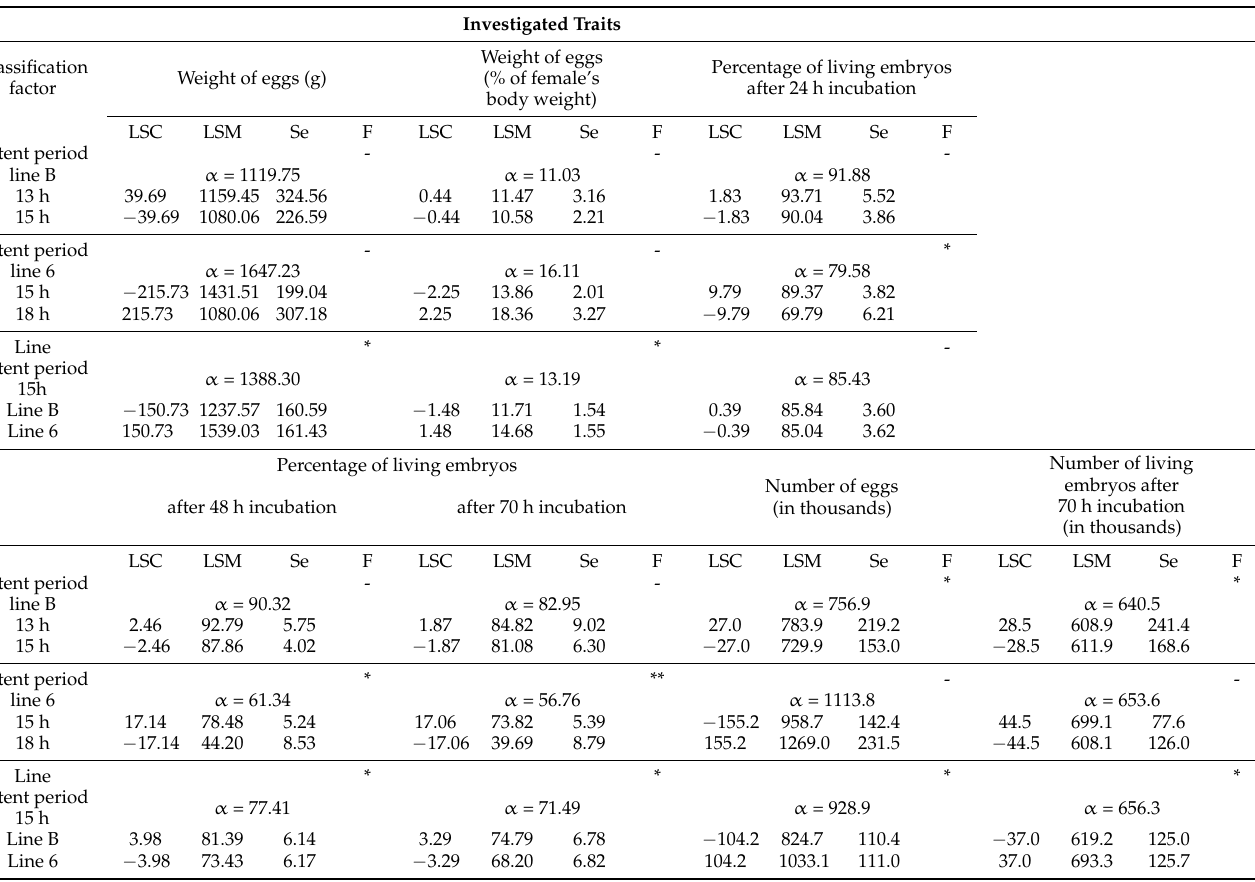
Table 2. Constants (LSC) and least-squares means (LSM) characterizing the reproductive effectiveness of two breeding lines of common carp ( Cyprinus carpio L.) associated with the latent period and results of the